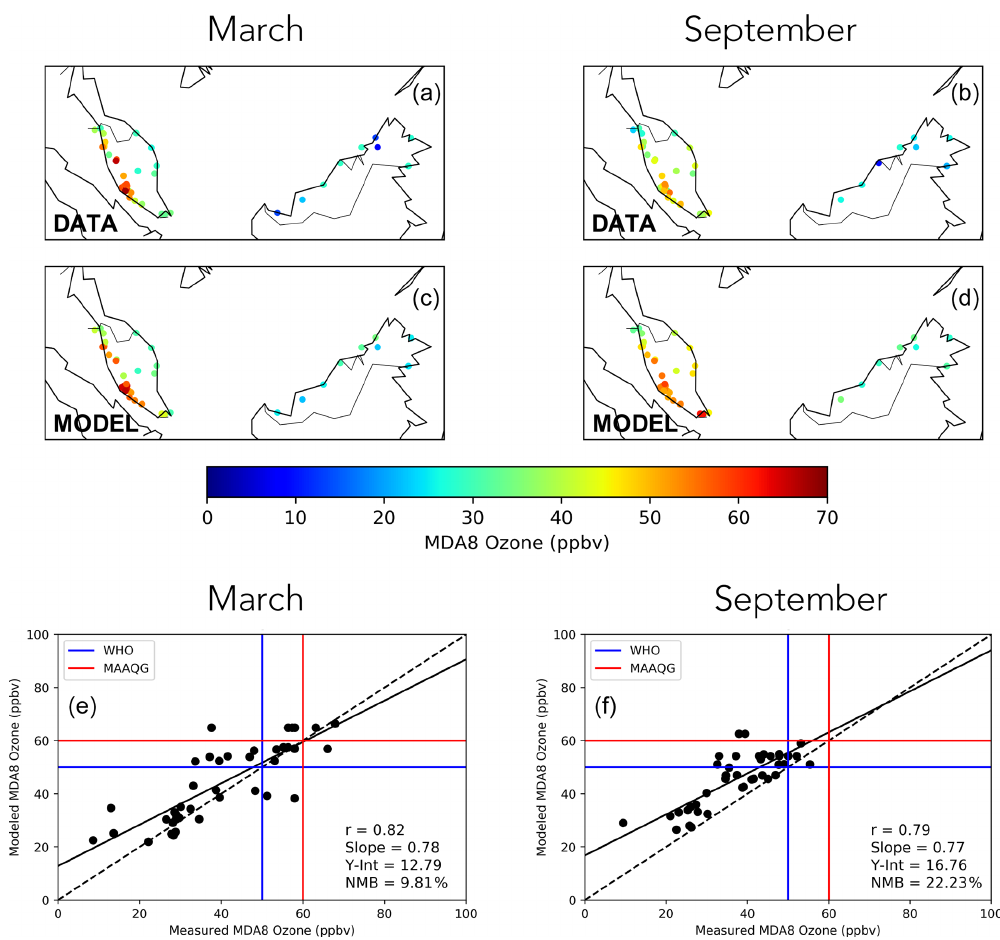
Figure 11. Monthly mean MDA8 ozone (ppbv) across Malaysia in March and September 2014. (a–d) Observed and GEOS-Chem spatial distribution of MDA8 ozone at air quality monitoring sites. (e, f) Scatterplot of observed and GEOS-Chem MDA8 ozone at the air quality sites. A line of best fit is shown in black, with the associated mean statistics shown in the inset: Pearson correlation ( r ), the slope and y intercept of the best-fit line, and the normalized mean bias (NMB) as defined in the main text. Blue and red lines denote WHO and MAAQG MDA8 limits as of